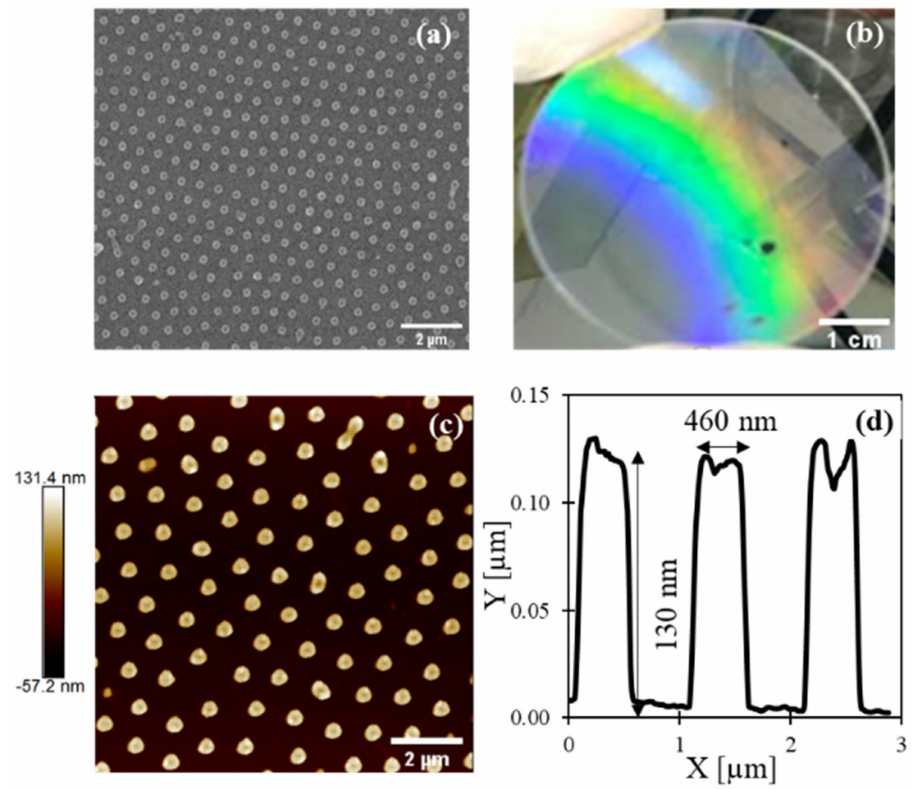
Figure 5. ( a ) SEM top view image. ( b ) Optical photograph of the micro- nanostructured sample. ( c ) AFM images. ( d ) Profile of the